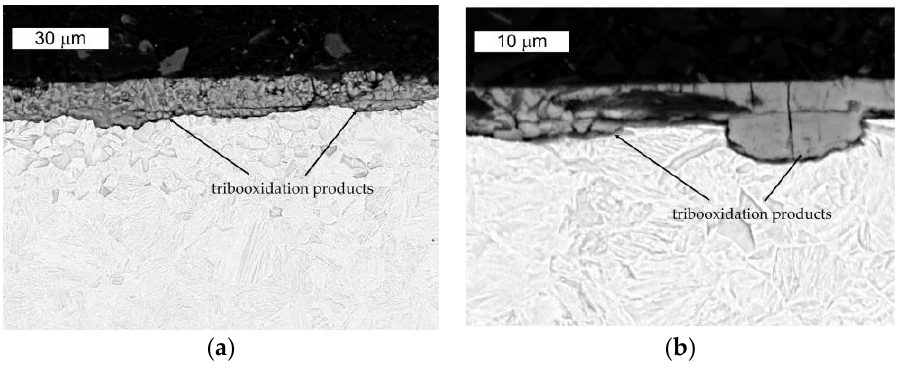
Figure 16. View of ( a ) the microstructure of steel Hardox in the surface area and ( b ) a magnified fragment of the area in Figure 16a in the transverse direction to the direction of the friction track. SEM, etched.